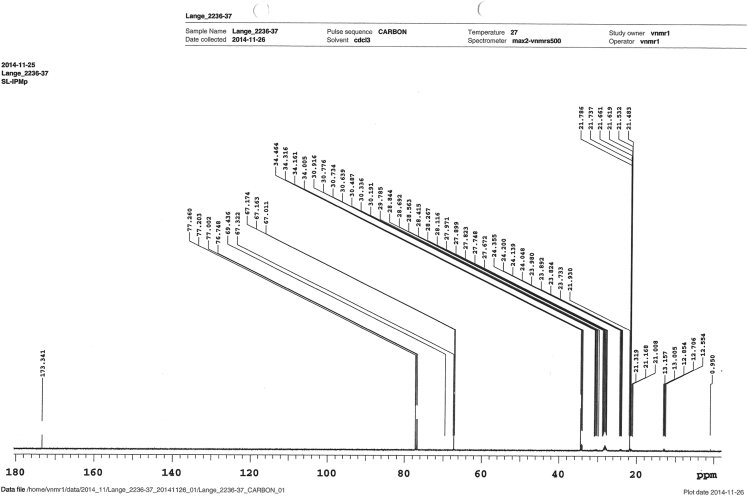
13C-NMR-spectrum of the purified IPMdeut.